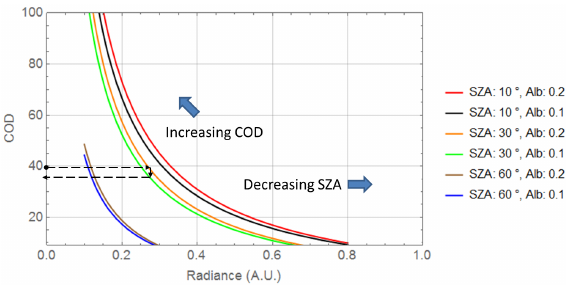
Figure 9. Retrieved COD sensitivity to change in ground albedo from 0.1 (left curves) to 0.2 (right curves) for three different SZA curve pairs, computed using asymptotic RT relations. See text for